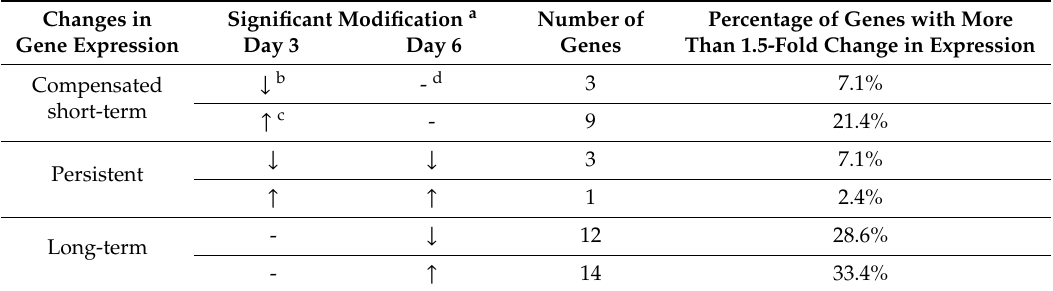
Table 1. Overview of gene expression modulation following conditional osteopontin knockdown. Changes in Gene